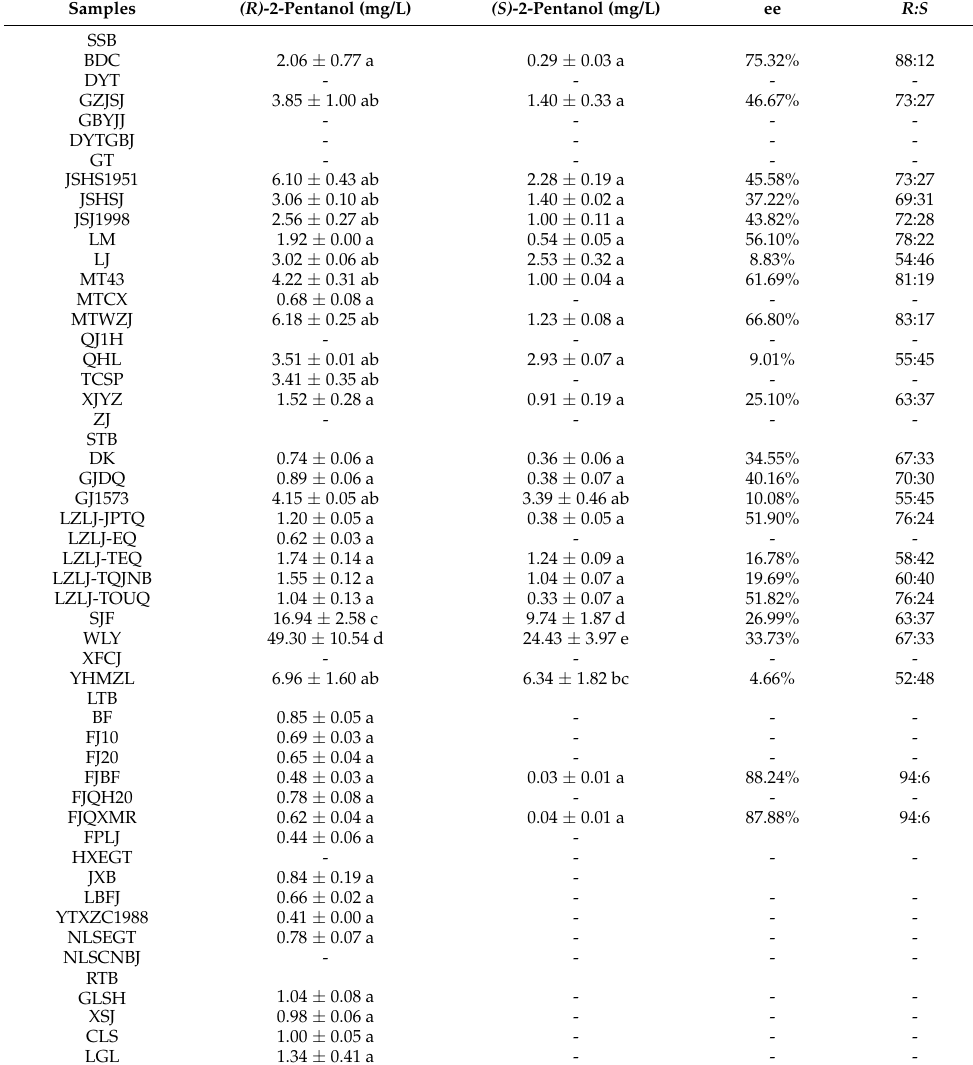
Table 4. Enantiomeric content and ratio of 2-pentanol in Baijiu analyzed by LLE-GC-MS.